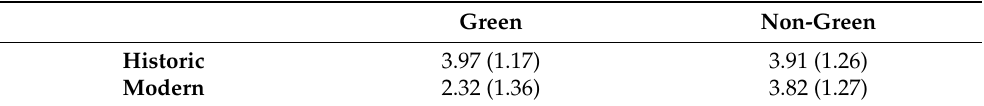
Table 5. Participants’ familiarity with the visual stimuli, M(SD). 5 = ‘I am very familiar’, 1 = ‘I am not familiar at all’.